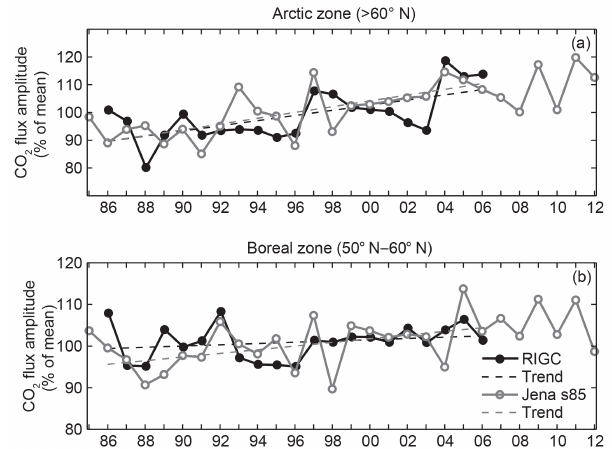
Figure 4. CO 2 flux amplitude for each year calculated as the maxi- mum monthly flux (positive: CO 2 release to the atmosphere) minus the minimum monthly flux (negative: CO 2 uptake by the biosphere) for (a) arctic zone and (b) boreal zone. Black shows the RIGC in- version; grey shows the Jena s85 inversion. Dashed lines show the linear trends from 1986 to 2006, the common period between the inversions (Table 2).